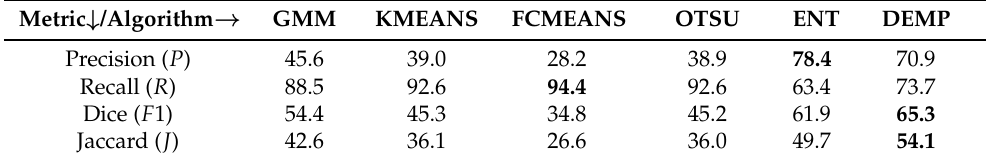
Table 2. Averaged metric values obtained on crack segmentation dataset. The best values are in bold. Metric ↓ /Algorithm → GMM KMEANS FCMEANS OTSU ENT DEMP Precision ( P